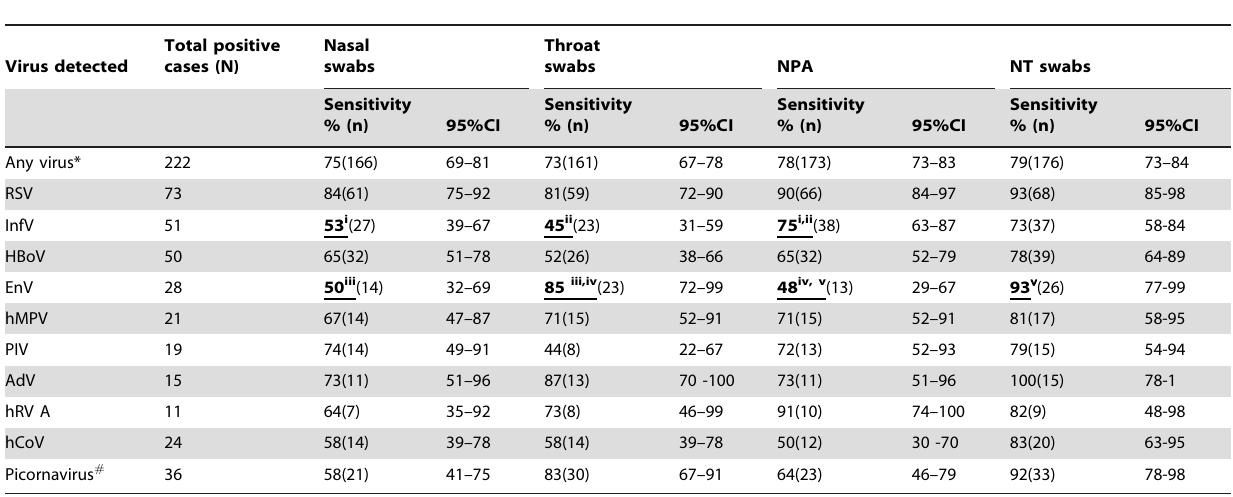
Underlined and bold numbers indicate significant differences in paired values by McNemar’s test: i between nasal swabs and NPA (p=0.05); ii between NPA and throat swabs (p=0.006); iii between nasal swabs and throat swabs (p=0.01); iv between throat swabs and NPA (p=0.02); v between NT swabs and NPA (=0.001). *refers to the total number of positive cases, defined as the detection of any viral pathogen in any specimen per patient. # refers to cases in whose samples enterovirus or human rhinovirus A was detected.